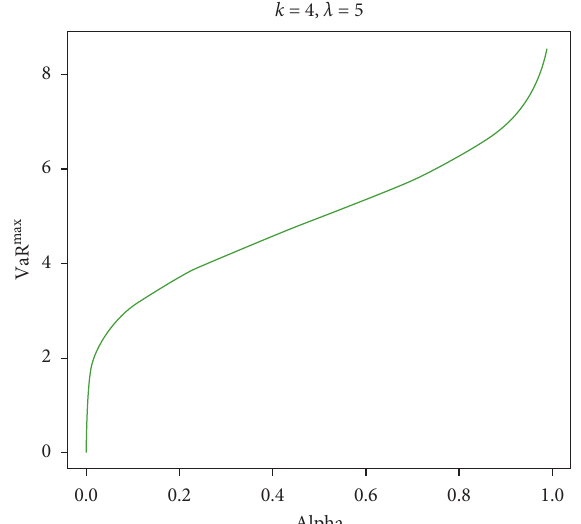
Figure 2: Maximum of the value at risk as a function of confidence level α for d